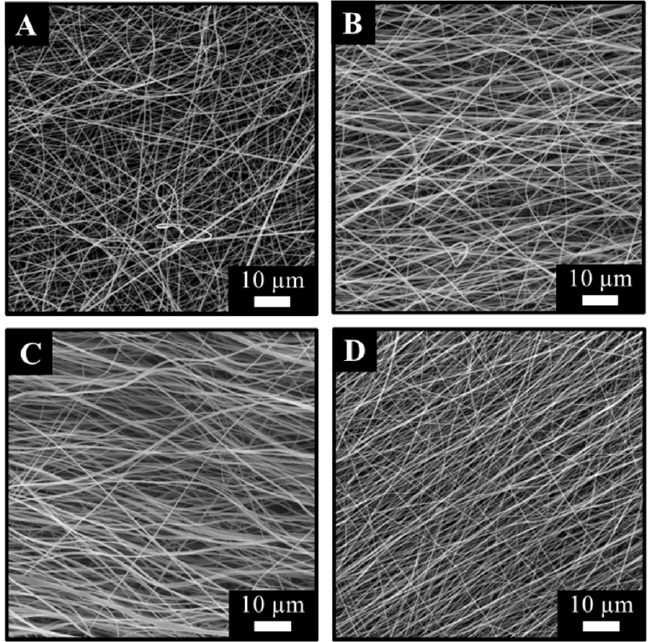
Figure 7. Scanning electron microscopy of electrospun membranes fabricated at ( A ) 500 rpm, ( B ) 2000 rpm, ( C ) 4000 rpm, and ( D ) 6000 rpm collector speeds.